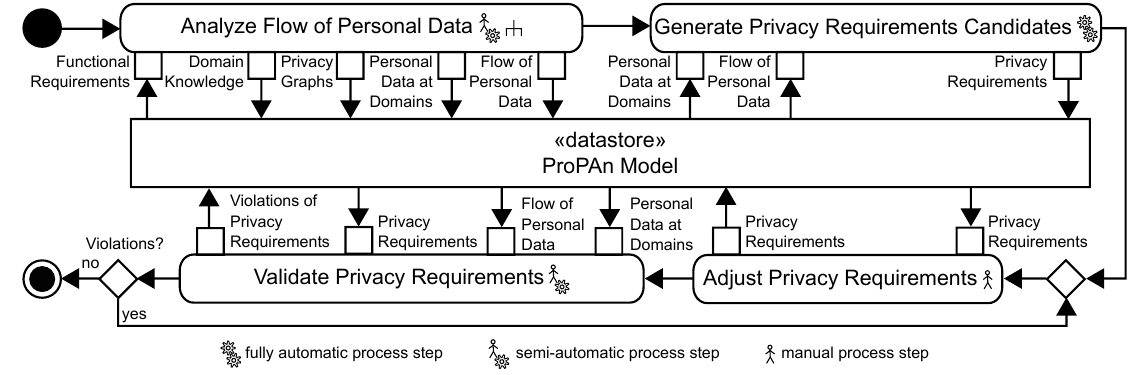
Figure 3. Overview of our proposed method.